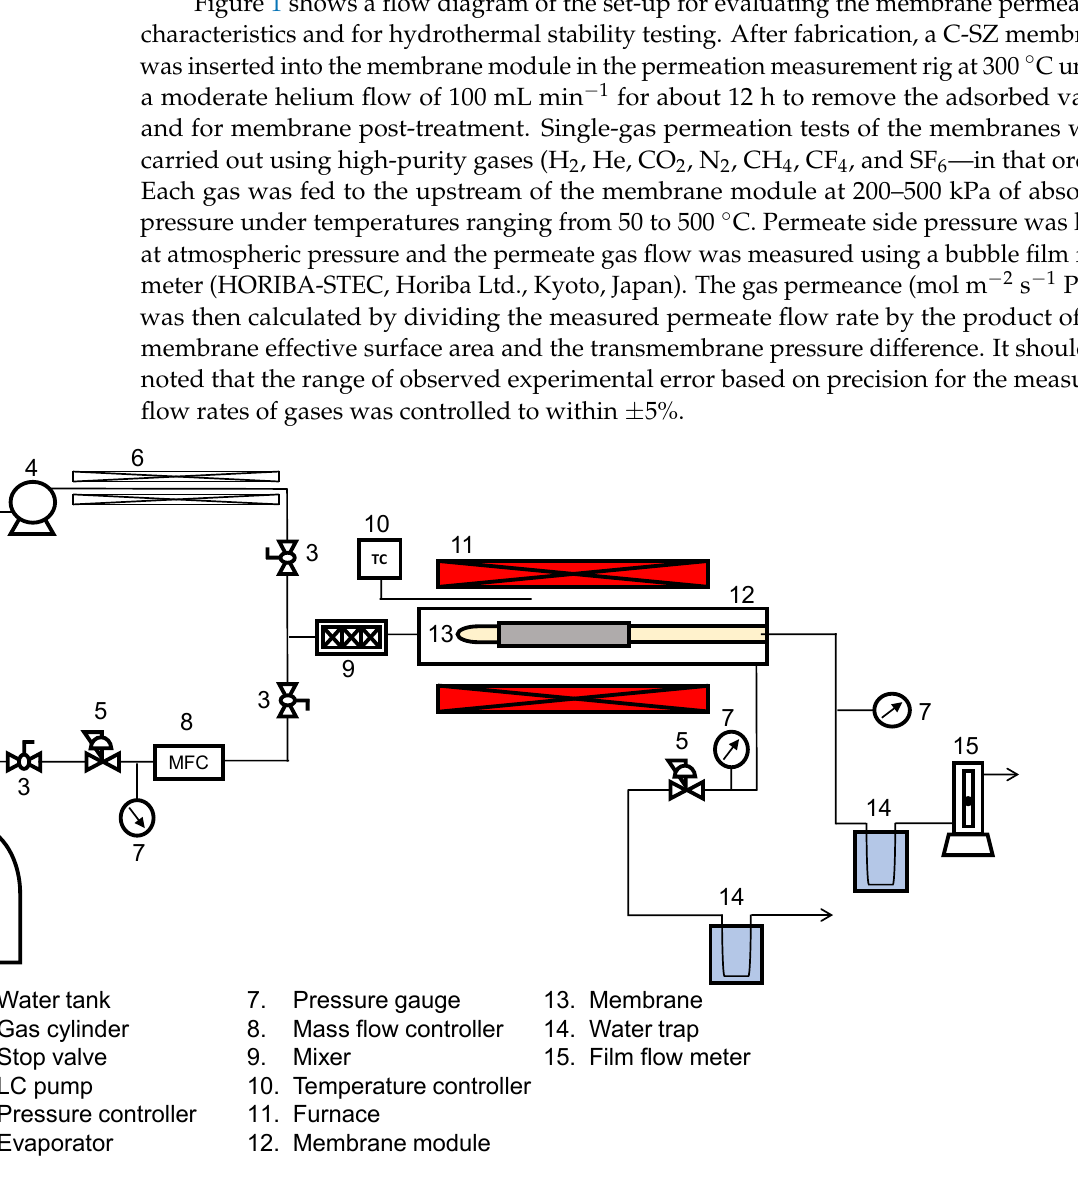
Figure 1. Schematic flow diagram of the membrane evaluation